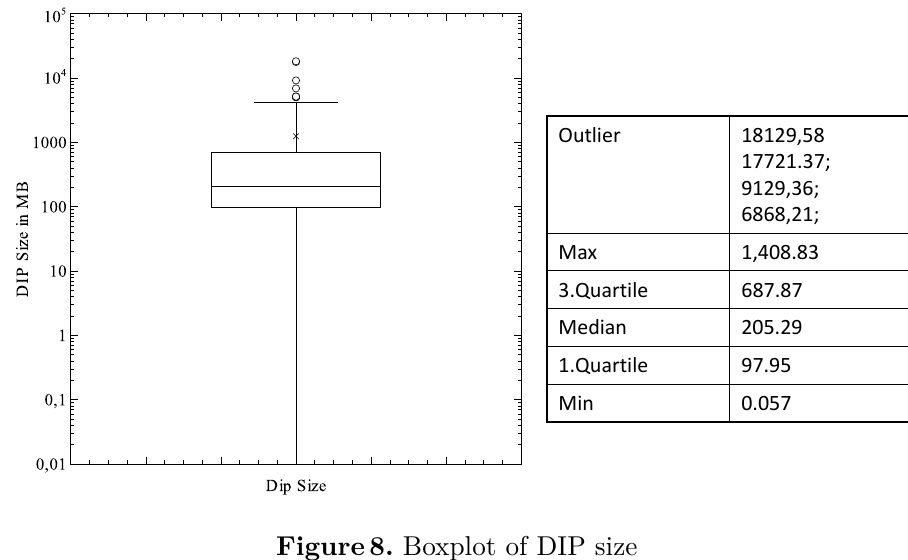
Figure 8. Boxplot of DIP